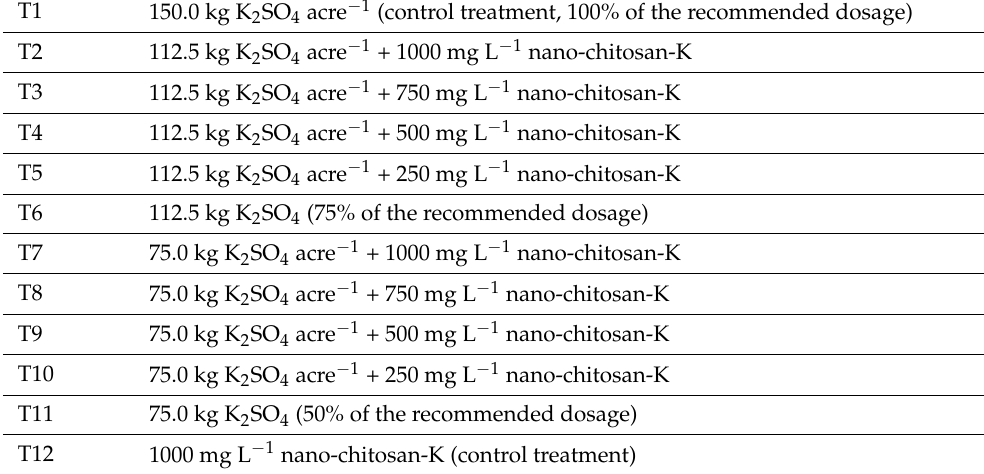
Table 2. The studied treatments and their